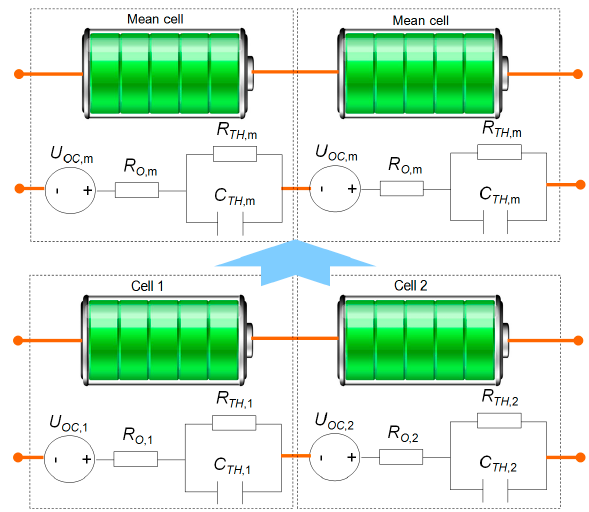
Figure 3. A simplified battery pack consisting of two series-connected individual cells.